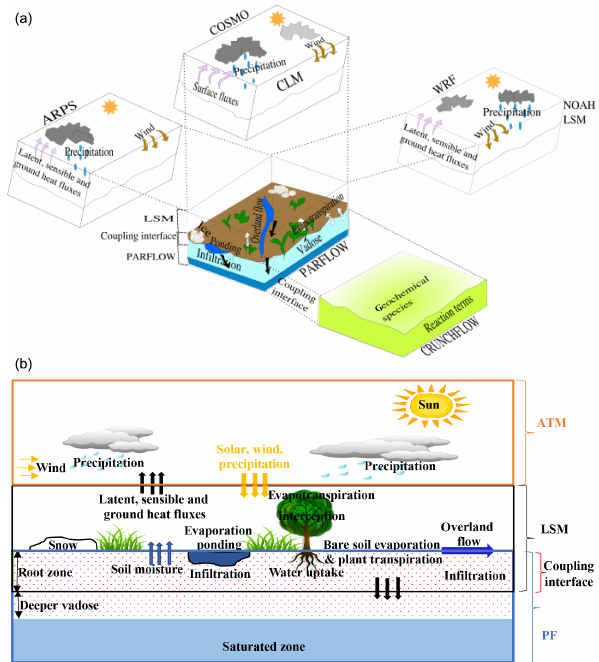
Figure 4. (a) A pictorial description of the relevant physical envi- ronmental features and model coupling. CLM represents the Com- munity Land Model, a stand-alone land surface model (LSM) via which ParFlow couples to COSMO. The modified version of CLM by Dai et al. (2003) is not shown because it is a module only for ParFlow, not really a stand-alone LSM any longer. The core model (ParFlow) always solves the variably saturated 3-D groundwater flow problem, but the various couplings add additional capabilities. (b) Schematic showing information transmission at the coupling in- terface. PF, LSM, and ATM indicate the portions of the physical system simulated by ParFlow, land surface models, and atmospheric models, respectively. The downward and upward arrows indicate the directions of information transmission between adjacent mod- els. Note: coupling between ParFlow and CrunchFlow (not shown) occurs within the